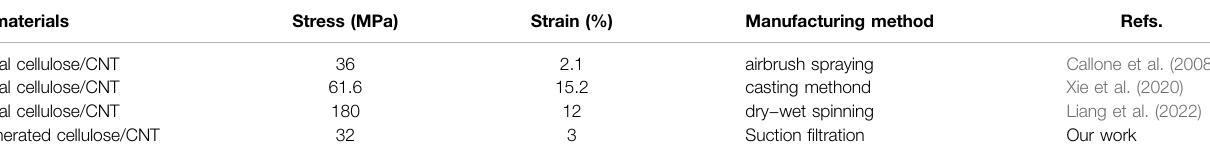
TABLE 2 | Summary of the mechanical properties of cellulose/CNT composite fi lms.